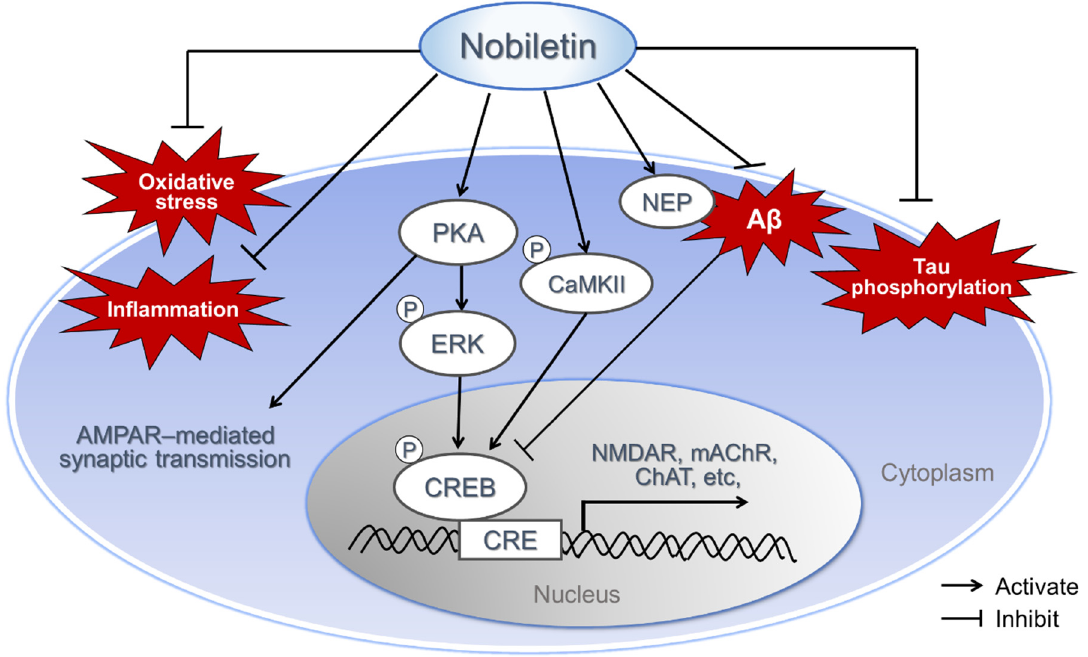
Figure 2. Potential neuroprotective effect of nobiletin. Nobiletin’s action mechanisms include various functions, such as antioxidant effects, anti-inflammatory effects, inhibiting A β production, increasing A β degradation, regulating gene expression through CRE-dependent transcriptional enhancement, inhibiting tau hyperphosphorylation, and regulating of synaptic plasticity. A β , β -amyloid; CaMKII, Ca 2+ /calmodulin–dependent protein kinase II; NEP, neprilysin; PKA, protein kinase A; ERK, extracellular signal-regulated kinase; CRE, cyclic adenosine monophosphate response element; CREB, CRE-binidng protein; NMDAR, N -methyl-D-aspartate receptor; mAChR, muscarinic acetylcholine receptor; ChAT, choline acetyltransferase; AMPAR, alpha-amino-3-hydroxy-5-methyl-4-isoxazolepropionic acid receptor. 3. Tangeretin 3.